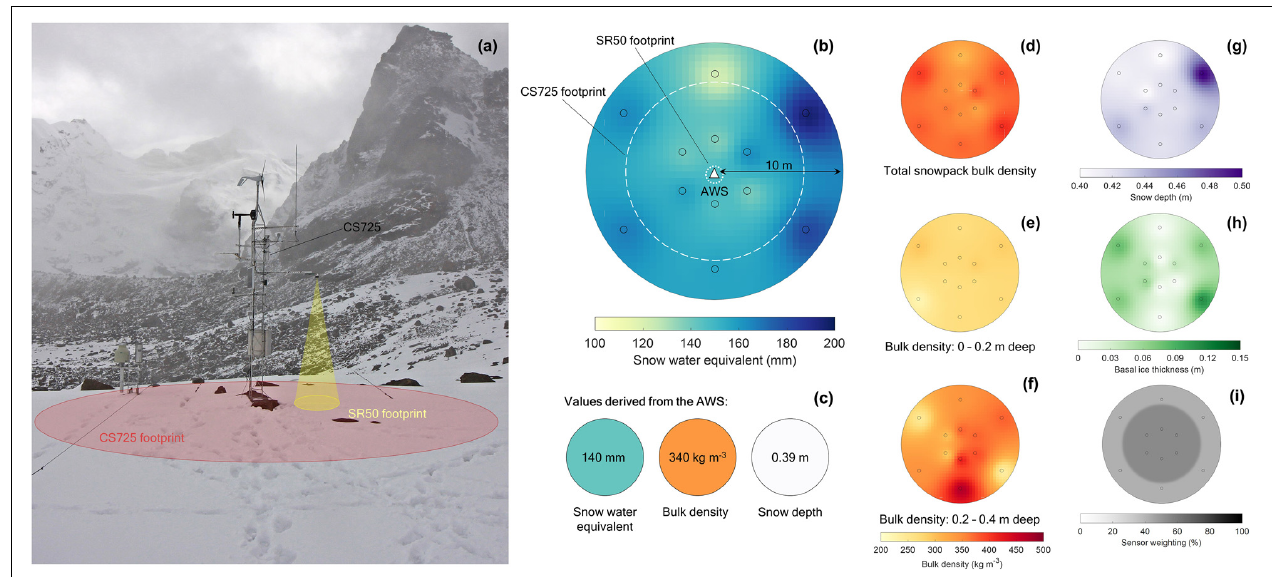
FIGURE 7 | Comparison between snow pit SWE, bulk density and snow depth values and those derived from the CS725 and the snow depth sensor. (a) The automatic weather station displaying the effective footprints of the CS725 and the SR50AT snow depth sensor. (b) Spatial distribution of SWE derived from snow pit density and snow depth measurements around the automatic weather station (AWS). (c) SWE, bulk density and snow depth derived from the CS725 and the SR50AT. (d–f) Snowpack bulk density for: (d) the entire snowpack, (e) 0–0.2 m deep, (f) 0.2–0.4 m deep, (g) snow depth, (h) basal ice thickness, and (i) Spatial weighting of the CS725 SWE